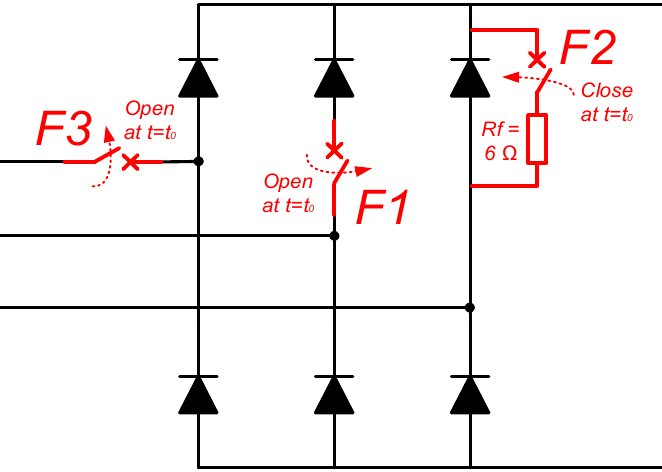
Figure 10. Experimental rectifier faulty condition test arrangement schema (F1: open-diode fault; F2: shorted-diode fault; F3: open-phase fault).